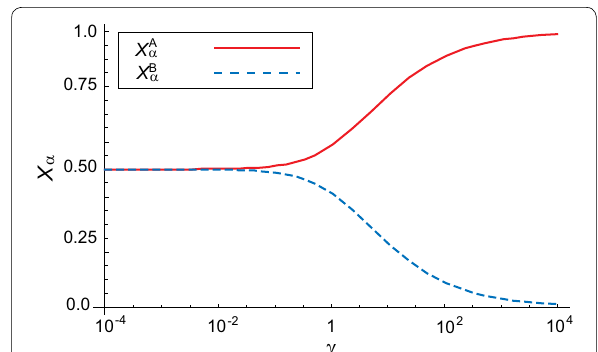
Fig. 4 The compositions of the precipitated minerals on the A and B sides as functions of γ when δ = 1 . The solid red and blue dashed lines indicate X A α and X B α , respectively. In case of small and large γ , the compositions of the precipitated minerals are considered to be homogeneous and heterogeneous, respectively